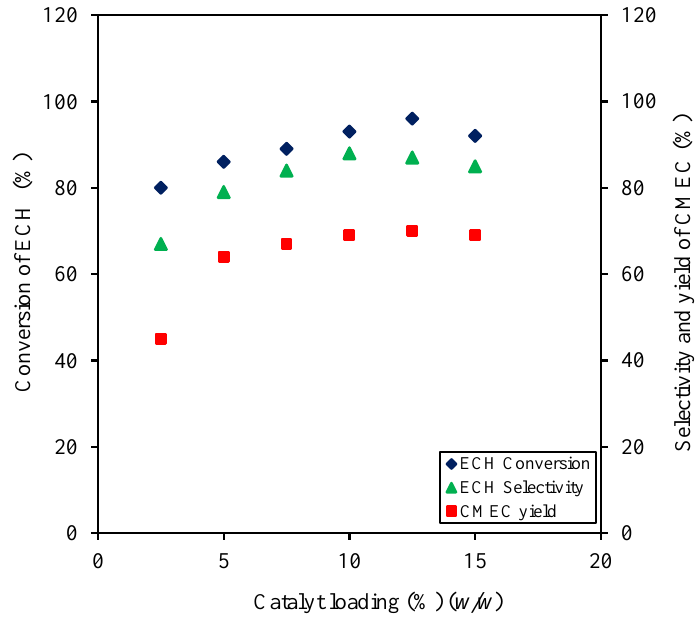
Figure 16. Catalyst loading dependence on conversion of ECH versus selectivity and yield of CMEC. Experimental conditions: catalyst Zr / ZIF-8; reaction temperature 353 K, ( w / w ); reaction time 8 h; CO 2 pressure 8 bar; stirring speed 350 rpm.